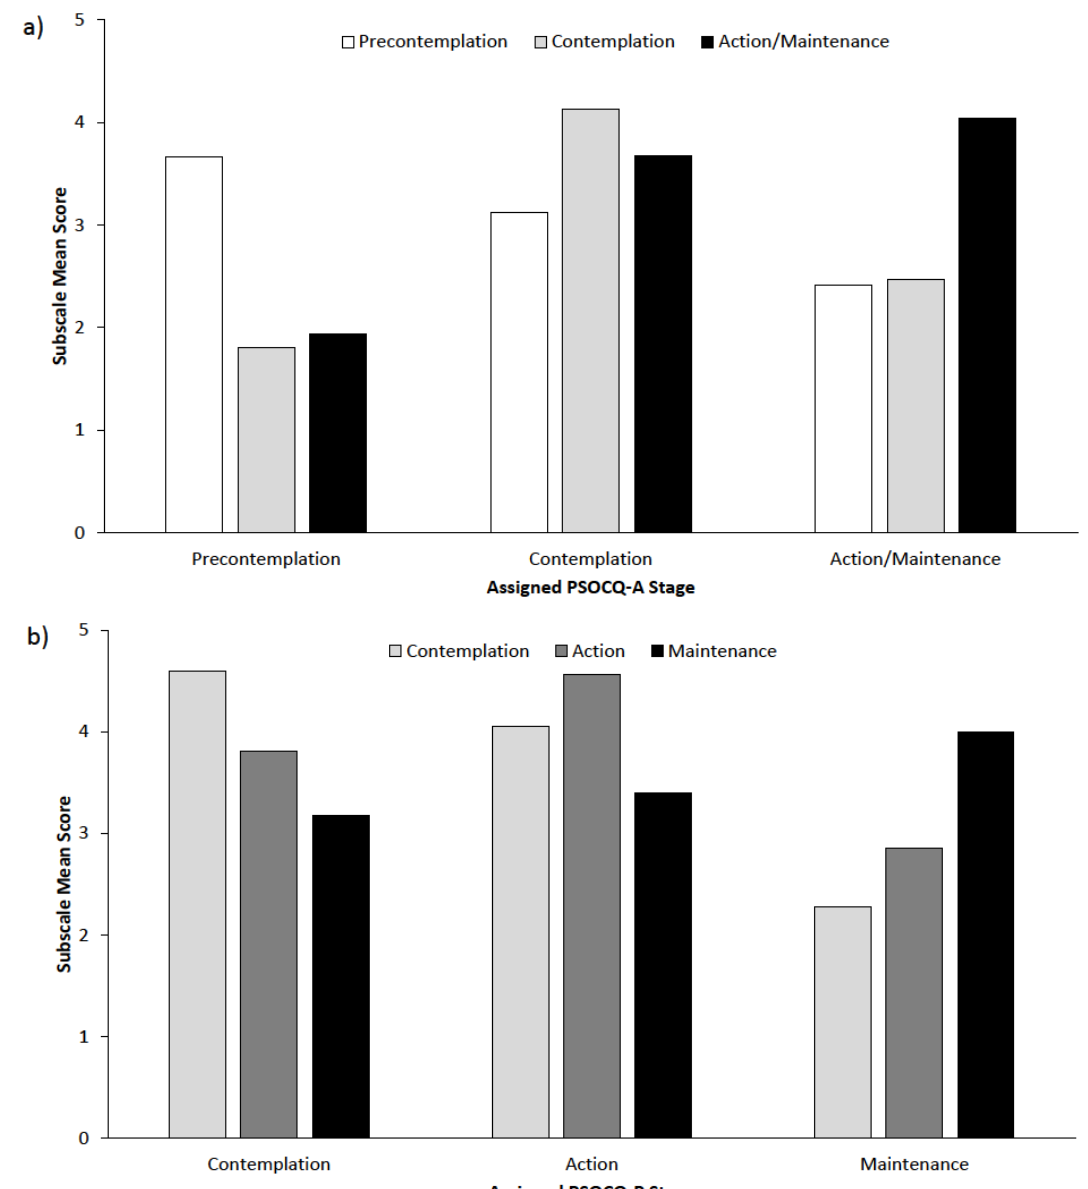
Figure 1. ( a ) Pain Stages of Change Questionnaire for Adolescents (PSOCQ-A) and ( b ) Pain Stages of Change Questionnaire for Parents (PSOCQ-P) subscale scores of the patients assigned to the different stages of change at admission. Note: Patients were assigned to one stage of change based on their highest subscale mean score at T1.